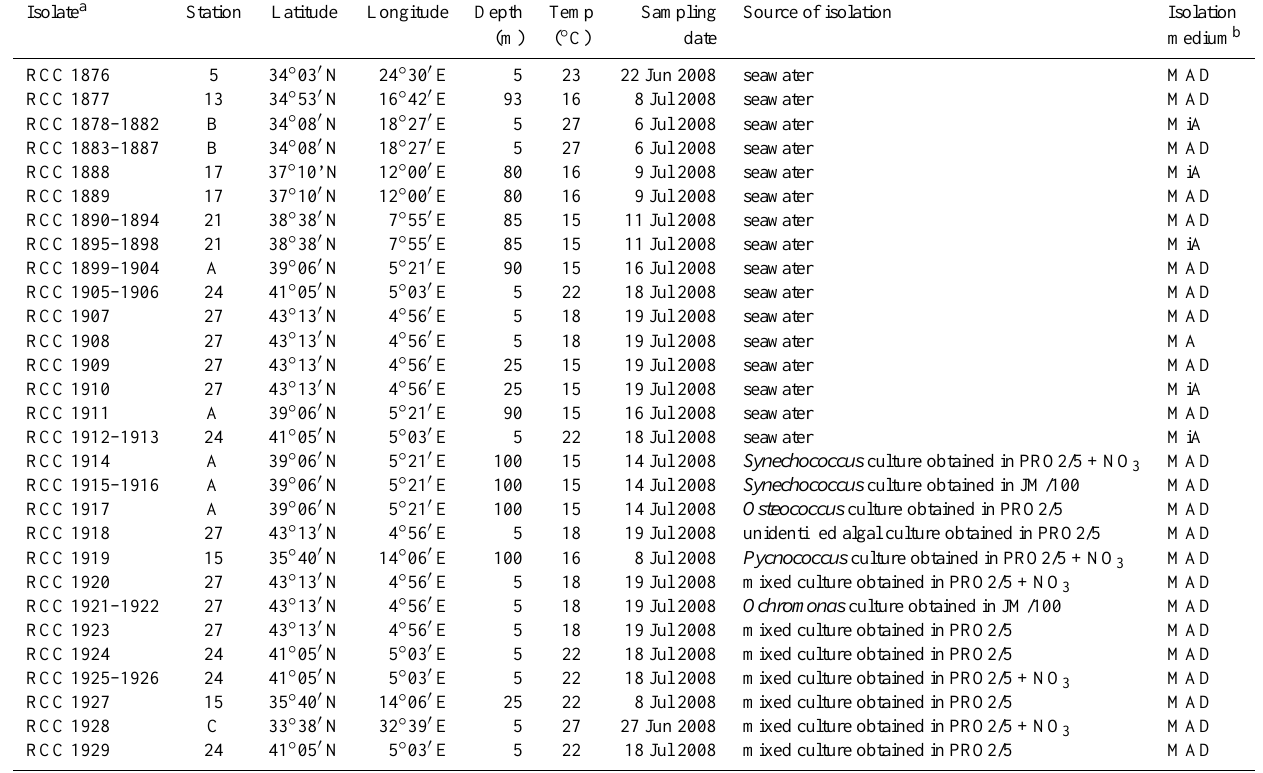
Table 1. Location, depth, temperature and date of sampling, source and medium of isolation of cultivated Mediterranean AAP bacteria. Isolate a